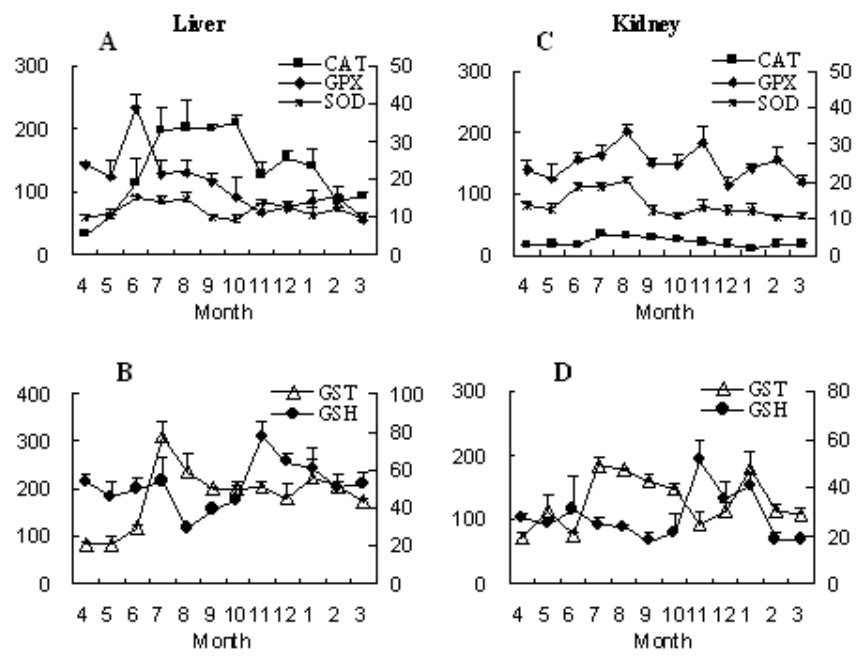
FIGURE 7. Seasonal variations of the activities of CAT (µmoles/min/mg protein), SOD (U/mg protein), and GPX (nmoles/min/mg protein), and GST (nmoles/min/mg protein), and GSH concentrations (µg/mg protein) in liver (A and B) and kidney (C and D) of bighead carp collected from the fish pen in Meiliang Bay of Taihu Lake during April 2004 and March 2005. Results was expressed mean ± SD (n =